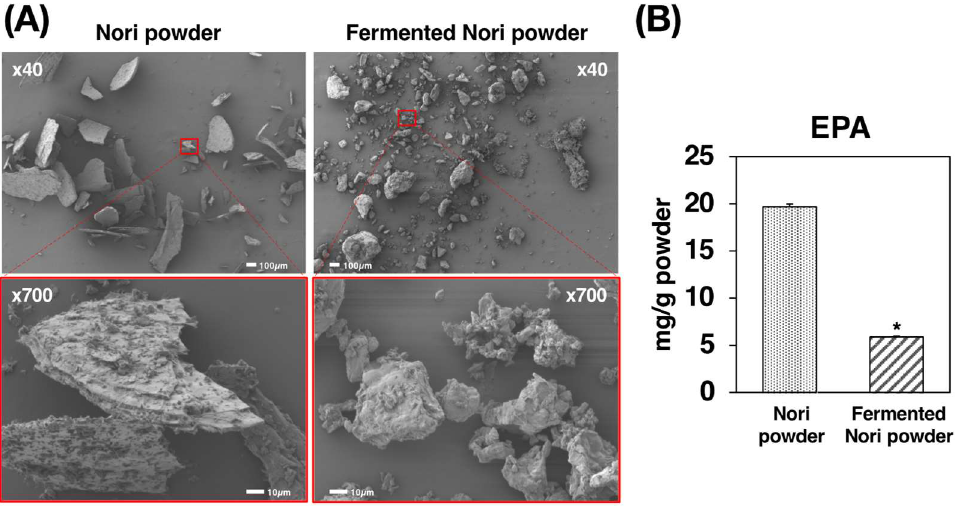
Figure 1. ( A ) Scanning electron micrographs and EPA contents of NP and FNP. ( B ) Values are ex- pressed as the mean ± standard error (n = 3). Asterisk shows significant difference ( p < 0.05) between the two powders. NP: Nori powder, FNP: fermented Nori powder, EPA: eicosapentaenoic acid.